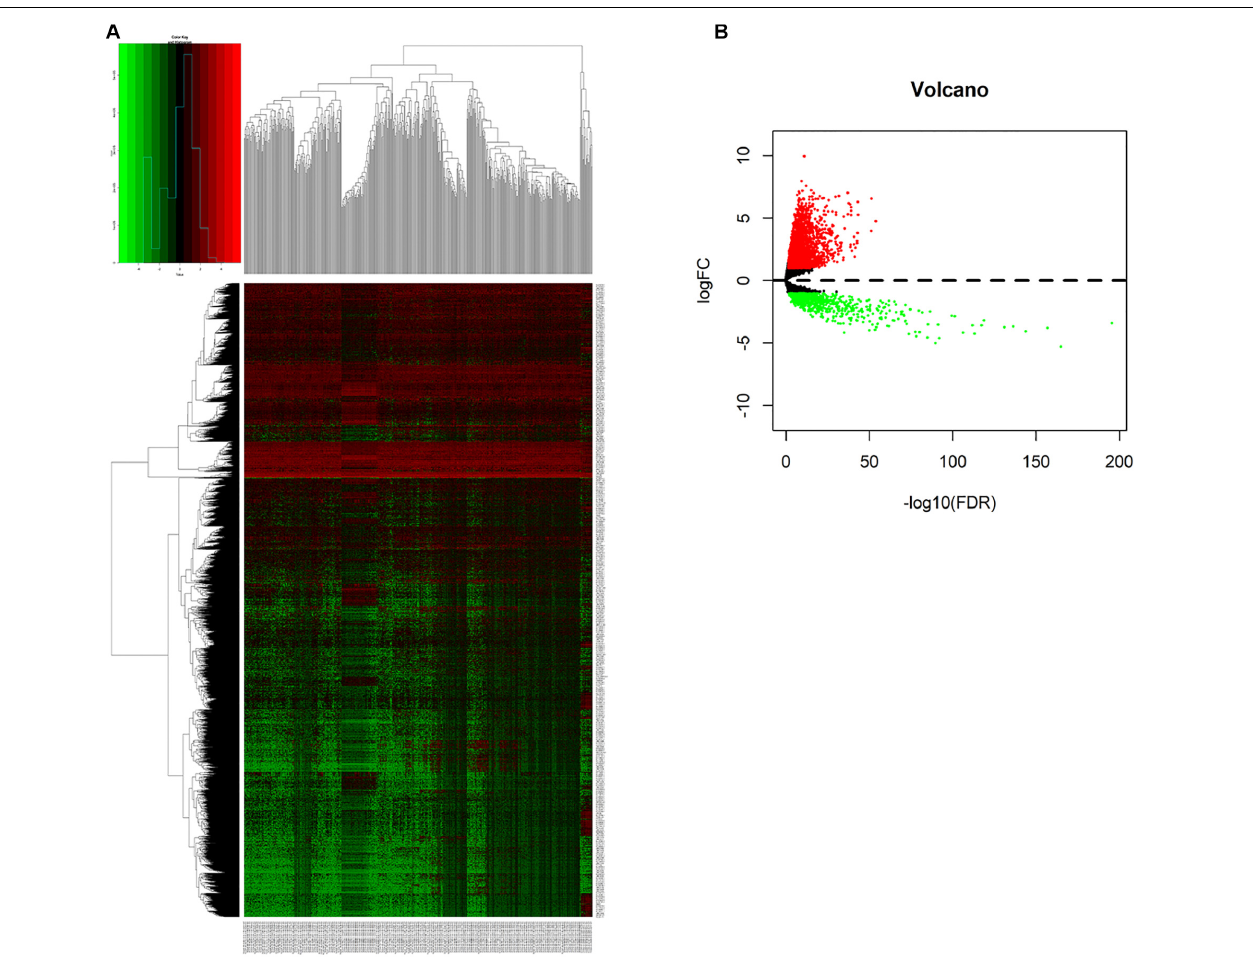
FIGURE 1 | Screening differentially expressed lncRNAs. (A) Heatmap of differentially expressed lncRNAs in lung cancer from TCGA-LUAD dataset. Red and green indicate up-regulated and down-regulated lncRNAs respectively. (B) Volcano plot of differentially expressed lncRNAs in lung cancer from TCGA-LUAD dataset. Red and green indicate up-regulated and down-regulated lncRNAs respectively.